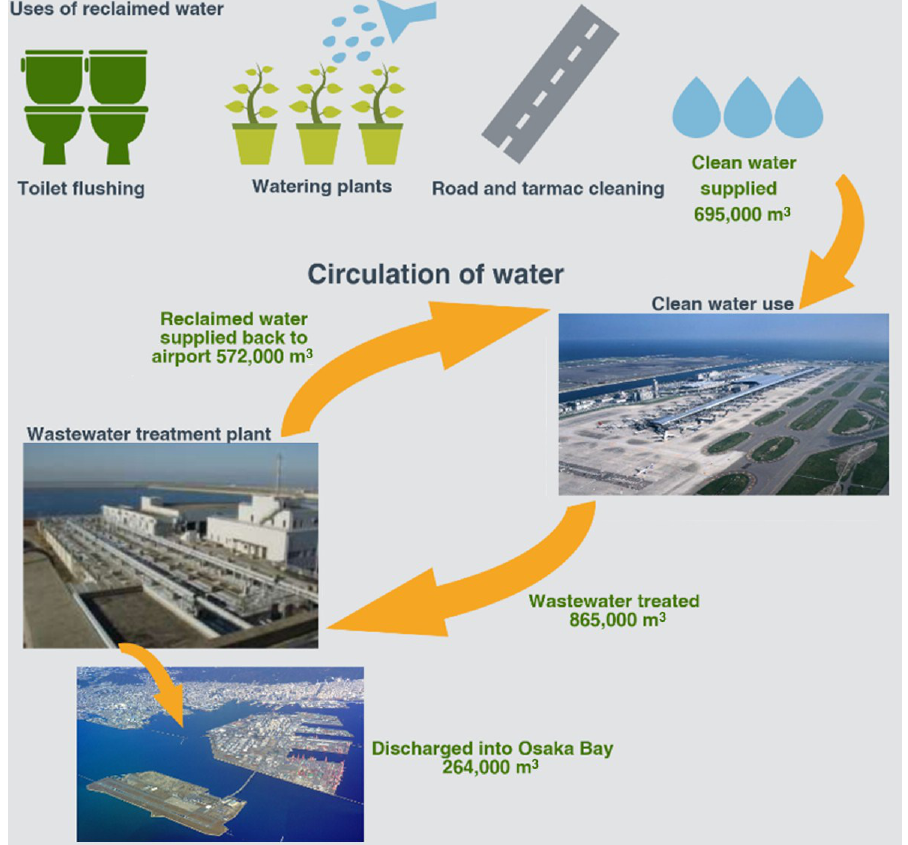
Figure 3. The circulation of water resources at Kansai International Airport. Source: adapted from Reference [11] (p.